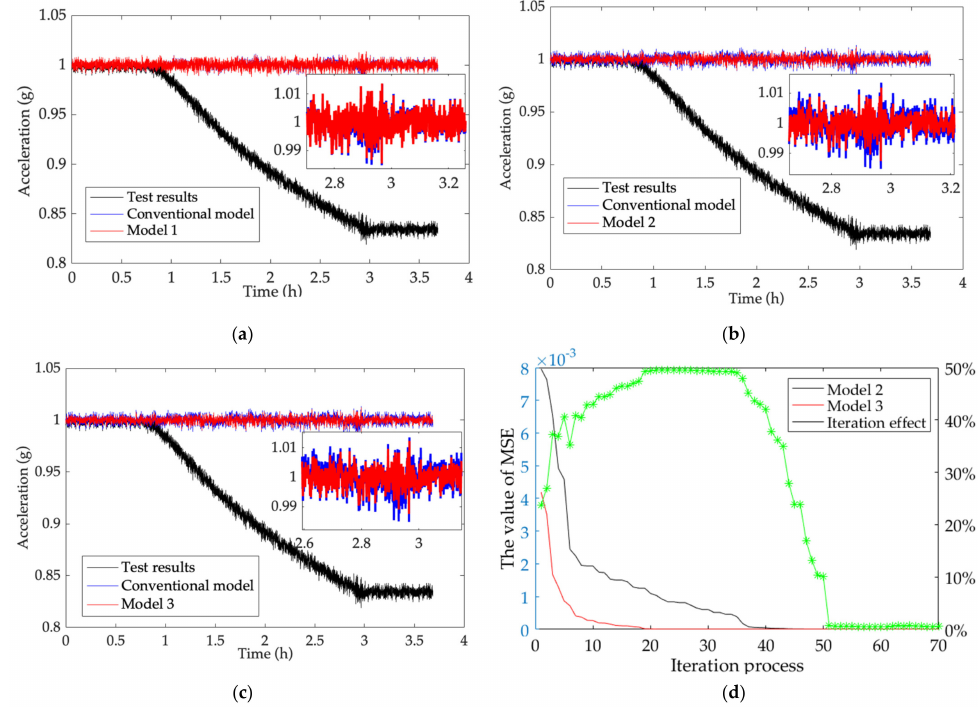
Figure 9. Comparison of performance improvement between the novel and the conventional mod- els. ( a ) Accuracy improvement of Model 1; ( b ) accuracy improvement of Model 2; ( c ) accuracy improvement of Model 3; ( d ) real-time improvement of Model 2 and Model